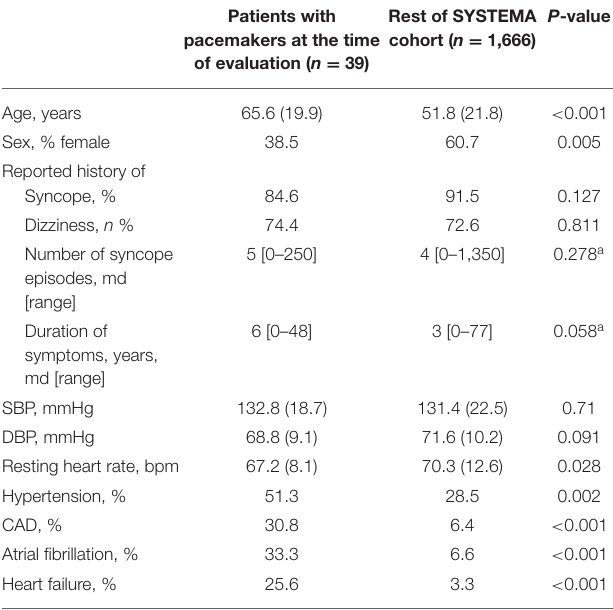
TABLE 1 | Patient characteristics ( n = 1,705) at the time of initial evaluation stratified according to pacemaker status. Patients with pacemakers at the